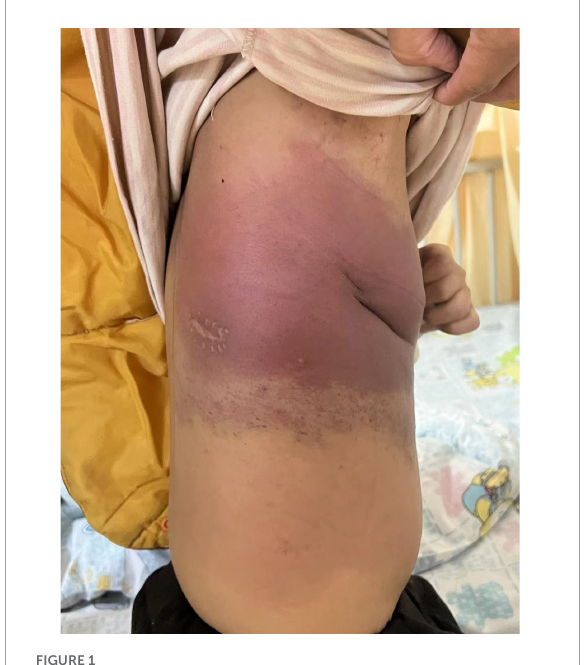
FIGURE1 Purpura on the right chest